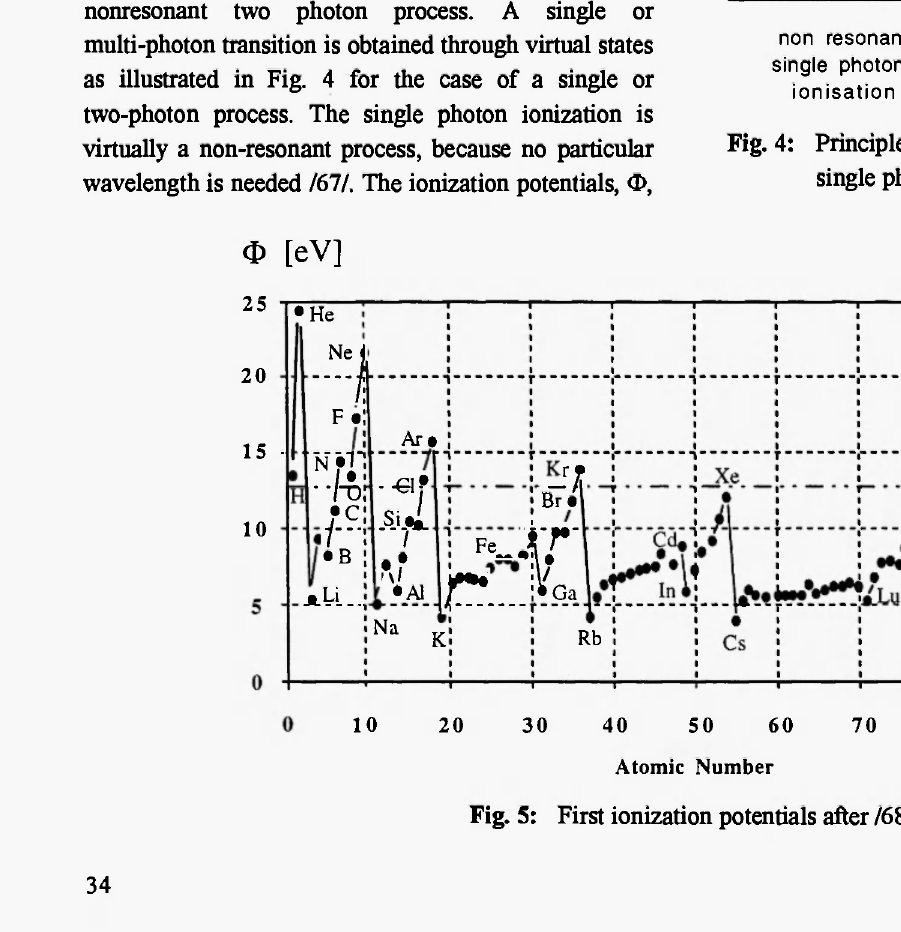
Fig. 4: Principle of non resonant post-ionization for